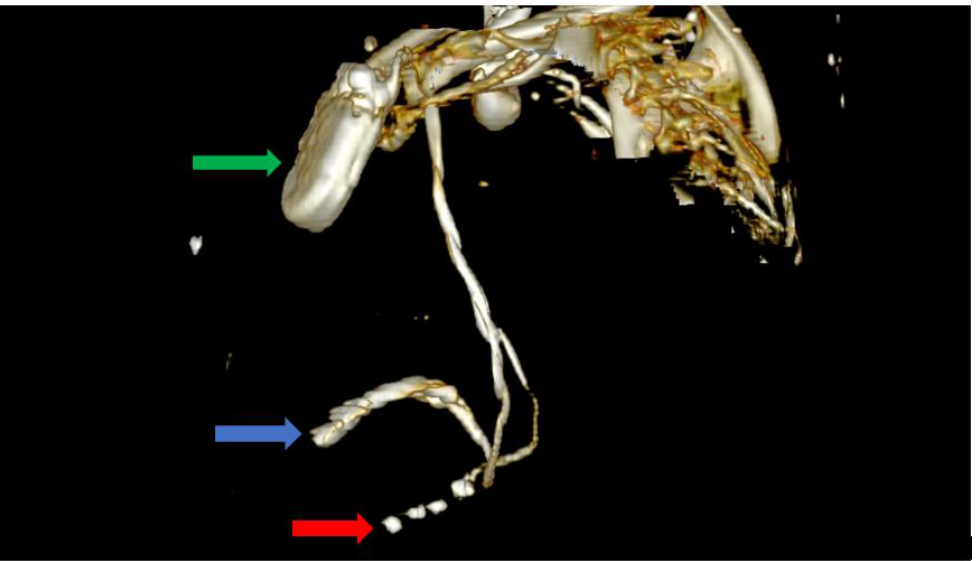
Figure 6. Computer tomography showing a left lateral view with the soft tissue removed from the image, as well as most of the skeleton. The image clearly shows the impulse generator (green arrow), the right ventricular lead implanted in the right ventricle forming a loop (blue arrow), as well as the tetrapolar CS lead adjacent to the right ventricle; the lead had migrated from its initial position in the CS (red arrow).